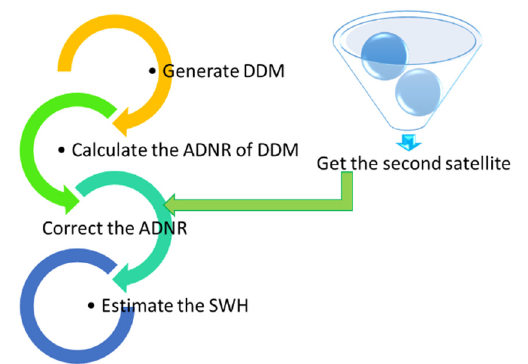
Figure 3. Procedure of the proposed algorithm.